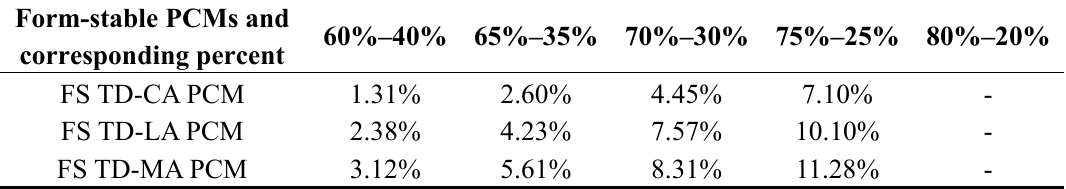
Table 4. Mass leakage percent of different kinds of form-stable PCMs. Form-stable PCMs and